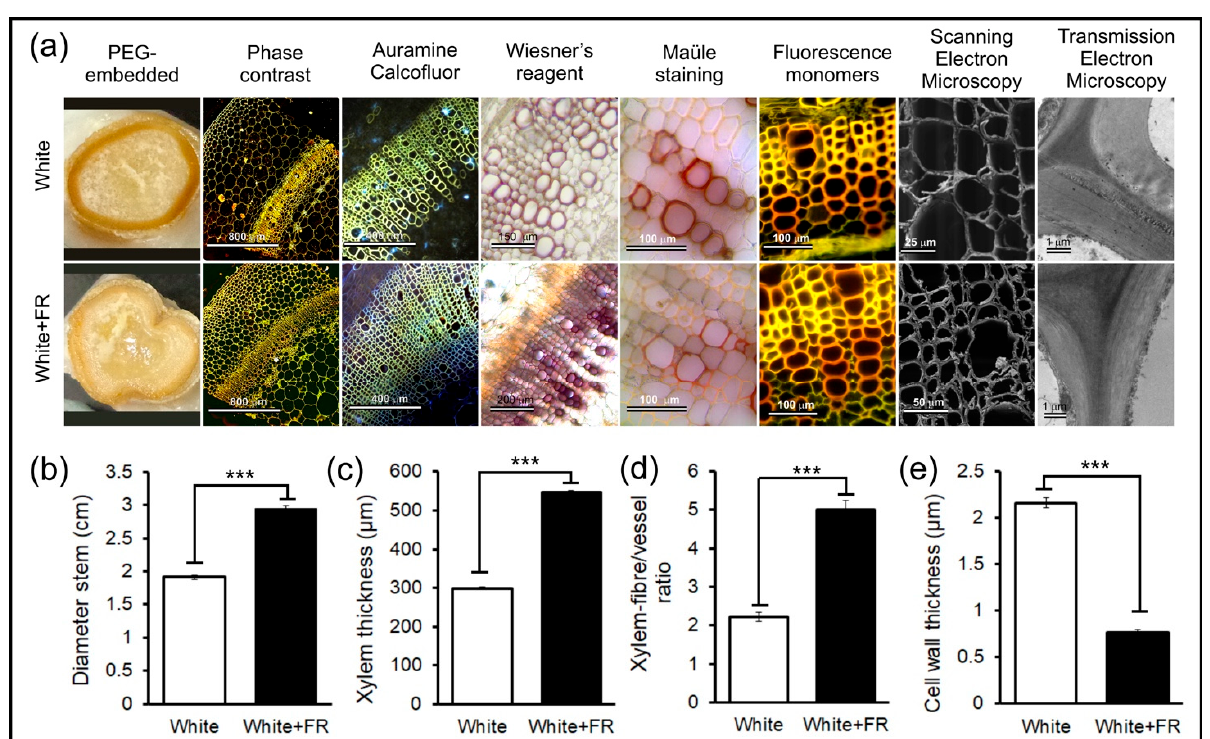
Figure 3. Qualitative and quantitative analyses of the structural and ultrastructural changes, as well as of the cell wall components of the stems of tobacco plants grown under White and White + FR conditions. Samples were fixed in Karnovsky’s solution, embedded in PEG 6000 and analysed using different staining techniques followed by fluorescence and electron microscopy. ( a ) From left to right: stem sections embedded in PEG 6000; stained with toluidine blue and analysed under light microscopy with phase contrast; blocks in methyl methacrylate stained with Auramine O and Calcofluor Bright White 28 and analysed using epifluorescence microscopy; lignified cells stained with Wiesner’s reagent and ana ‐ lysed under light microscopy; Mäule reagent showing lignin monomers under light microscopy; staining with astra blue